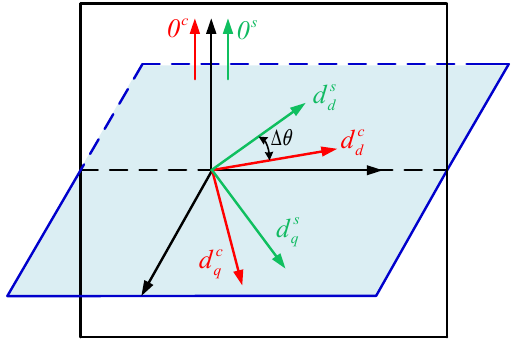
Figure 3. Relationship between the control d-q-0 frame and the system d-q-0 frame.